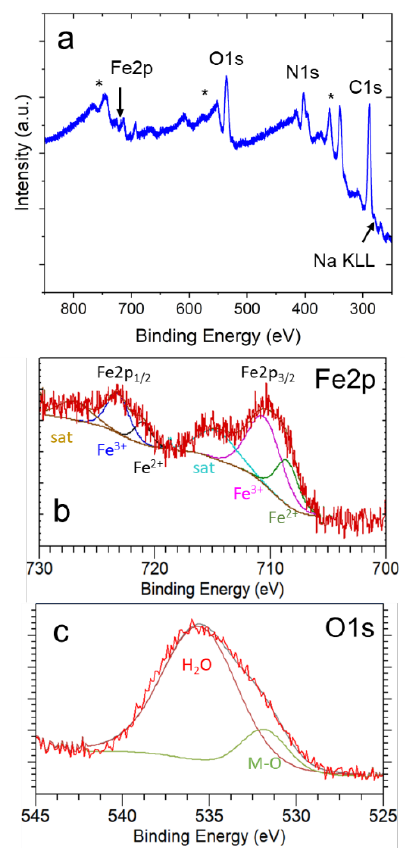
Figure 5. XPS results obtained from the surface of electrodeposited NaFeHCF layers: ( a ) overview spectrum, ( b ) detailed view of the Fe2p core level region, ( c ) detailed view of the O1s core level region. The stars in ( a ) mark the signals from the Au/Cr/Si substrate.